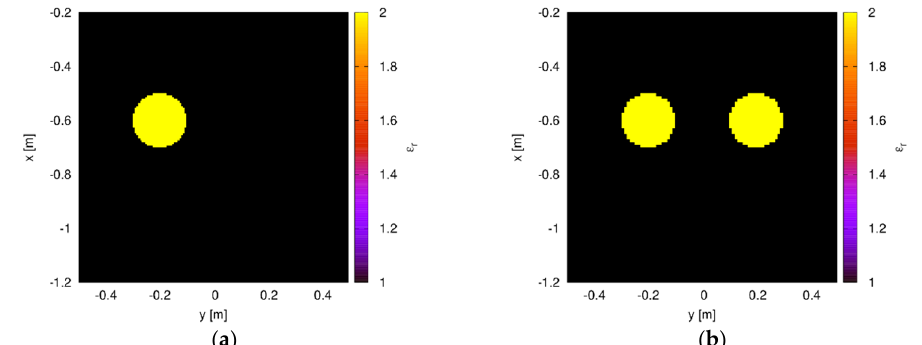
Figure 2. Actual configuration. ( a ) Single dielectric cylinder and ( b ) two separate dielectric cylinders.